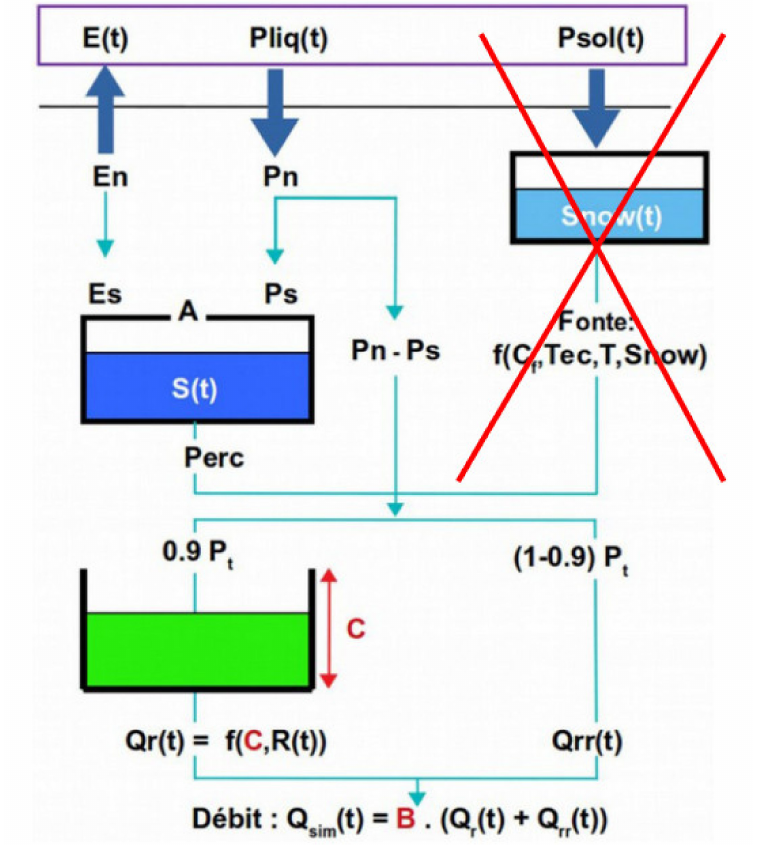
Figure 5. Schematic representation of the 2-parameter model GRLoiEau2J